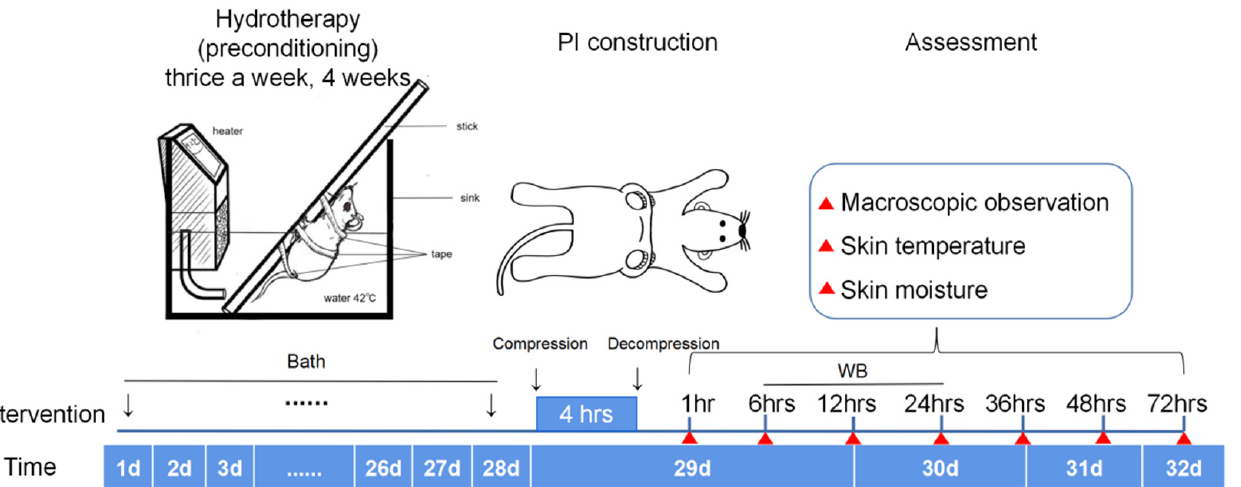
Figure 6. Protocol of the study design. PI: pressure injury. WB: Western blot.